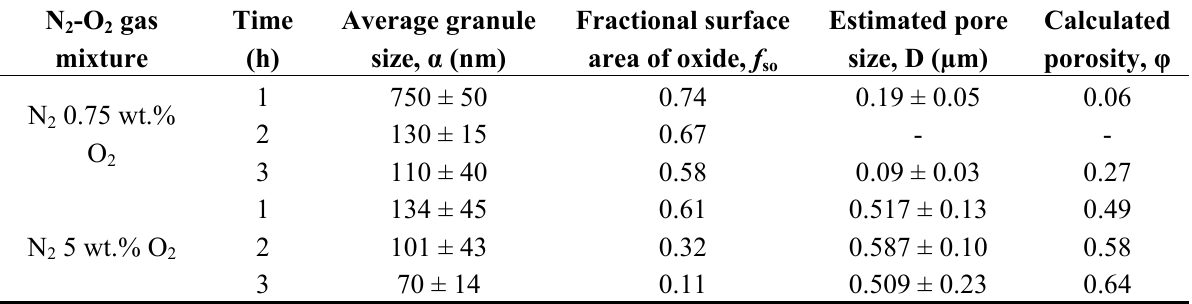
Table 1. The average oxide granule size, α ; the fractional surface area, f pore size, D ; and the calculated oxide layer porosity, φ